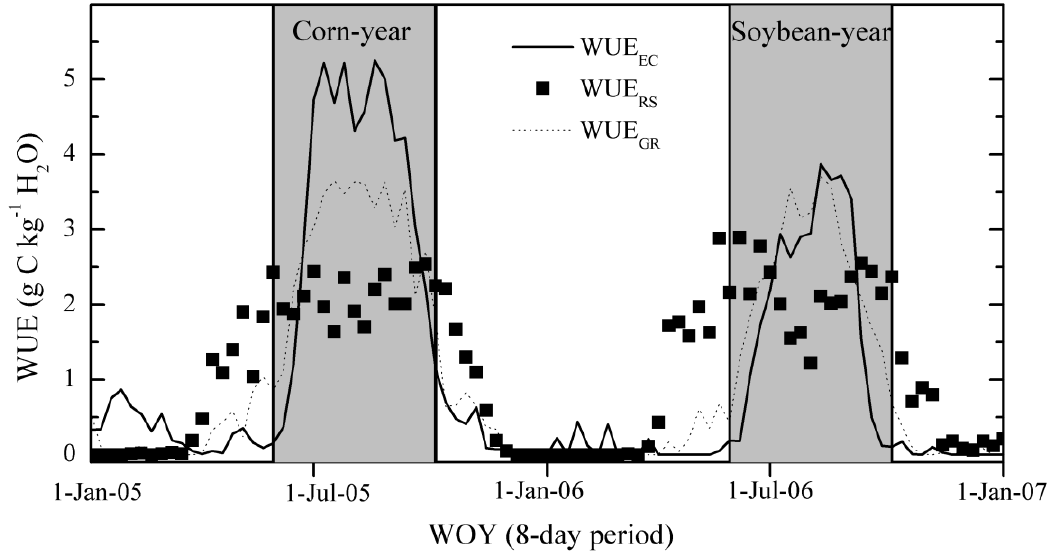
Figure 7. Seasonal dynamics in ecosystem WUE from flux tower measurements (WUE EC ), predicted from MODIS products (WUE RS ), and estimates based on MODIS EVI